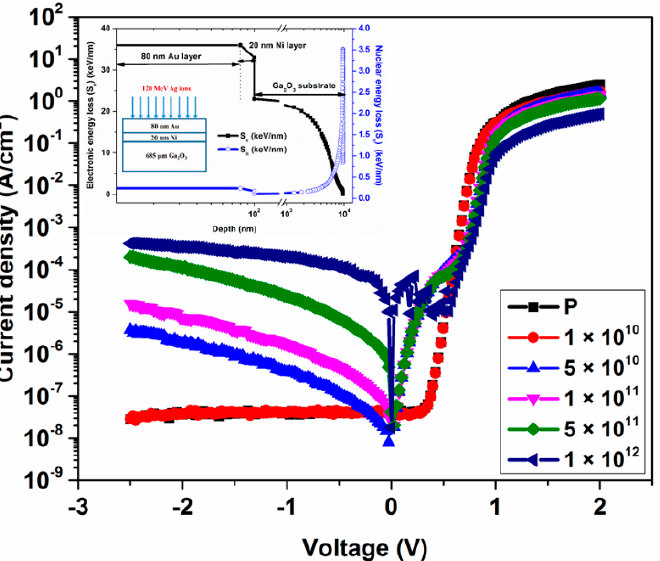
Figure 5. In situ current − voltage characteristics of Ni/ β -Ga 2 O 3 SBD; inset: variations of S e and S n of 120 MeV Ag 7+ ion beam with a function of depth. Reprinted/adapted with permission from Ref. [75],2020, AIP Publishing.